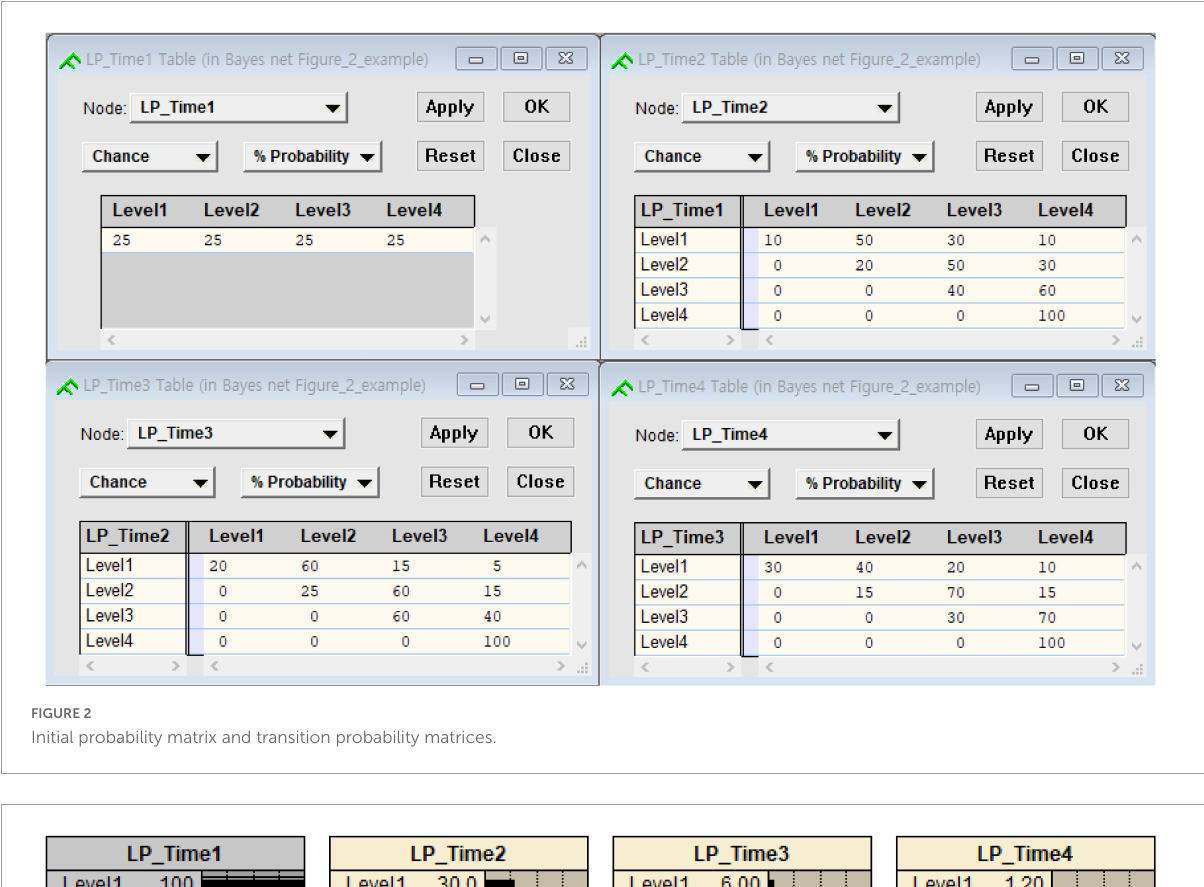
FIGURE3 A DBN representation of the four latent variables without tasks.